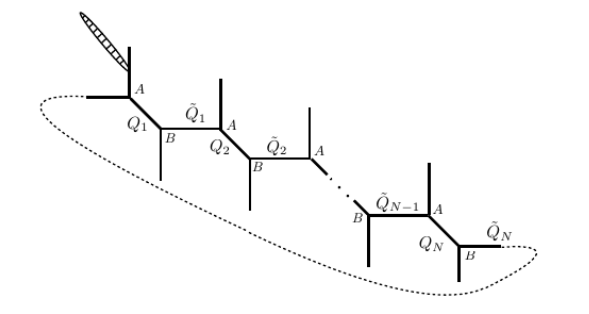
Figure 3: The periodic chain geometry with a lagrangian brane. The dashed line denotes the compactification along the horizontal